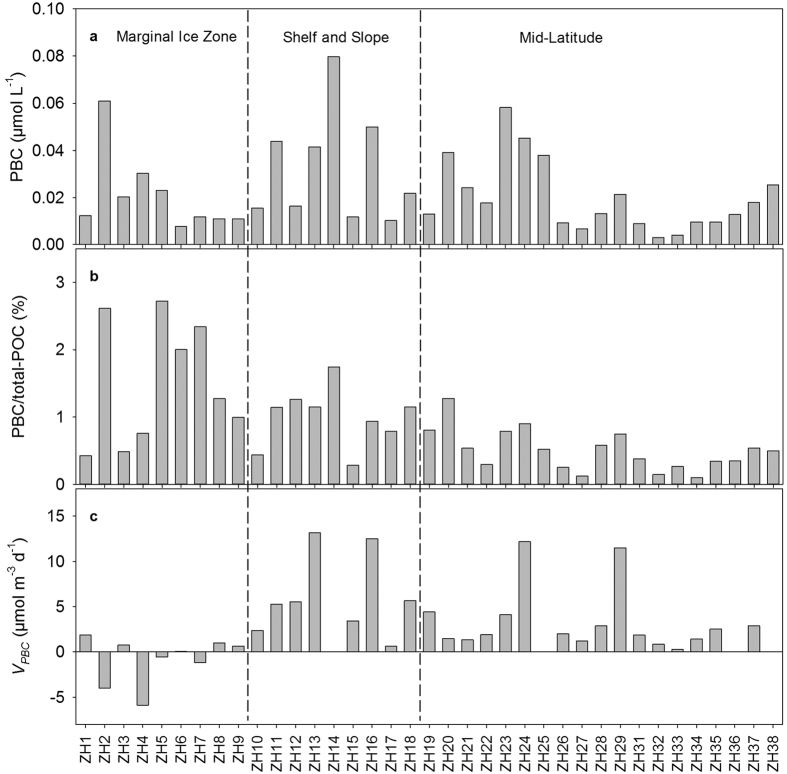
Latitudinal patterns of (a) PBC concentration, (b) ratio of PBC to the total-POC, and (c) input/sinking rate of PBC (VPBC).